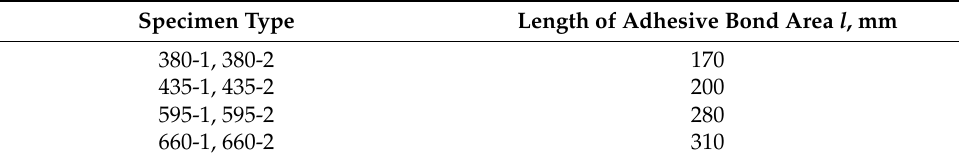
Table 1. Parameters used in the course of adhesive strength testing.